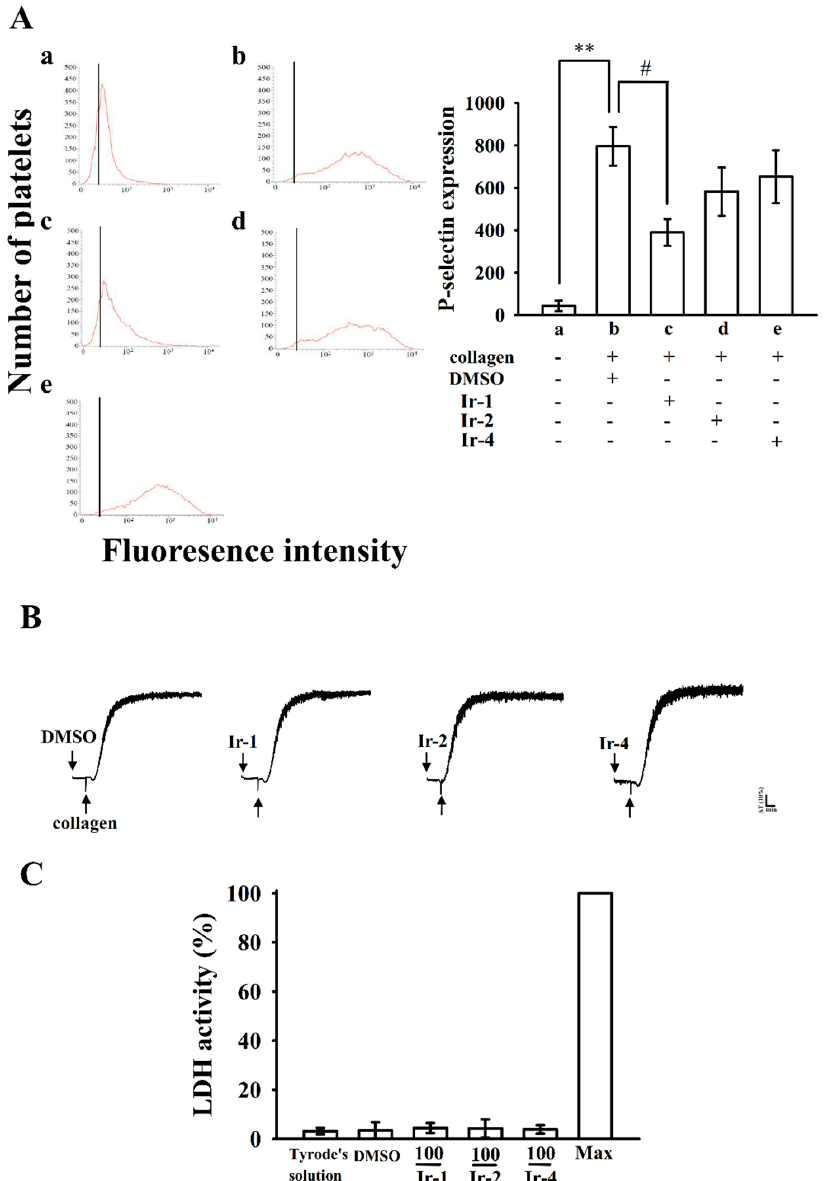
Figure 4. Effects of Ir-1, Ir-2 and Ir-4 on collagen-induced surface FITC-P-selectin expression and cytotoxicity in human platelets. ( A ) Washed human platelets (3.6 × 10 8 cells/mL) were preincubated with: ( a ) FITC only as a resting control; ( b ) the solvent control (0.1% DMSO); ( c ) Ir-1 (10 µ M); ( d ) Ir-2 (10 µ M); or ( e ) Ir-4 (10 µ M) for 3 min and subsequently treated with 1 µ g/mL of collagen to test the direct binding of FITC-P-selectin; ( B ) Washed platelets were preincubated with 0.1% DMSO or Ir-1, Ir-2 and Ir-4 (100 µ M) for 10 min and subsequently washed two times with Tyrode’s solution and collagen (1 µ g/mL) was then added to trigger platelet aggregation; ( C ) Washed platelets (3.6 × 10 8 /mL) were preincubated with 0.1% DMSO or with 100 µ M of Ir-1, Ir-2 and Ir-4 for 20 min, and a 10- µ L aliquot of the supernatant was deposited on a Fuji Dri-Chem slide LDH-PIII. Data are presented as the means ± S.E.M. ( n = 4). ** p < 0.01 compared with the DMSO group. # p < 0.05 compared with the collagen induced